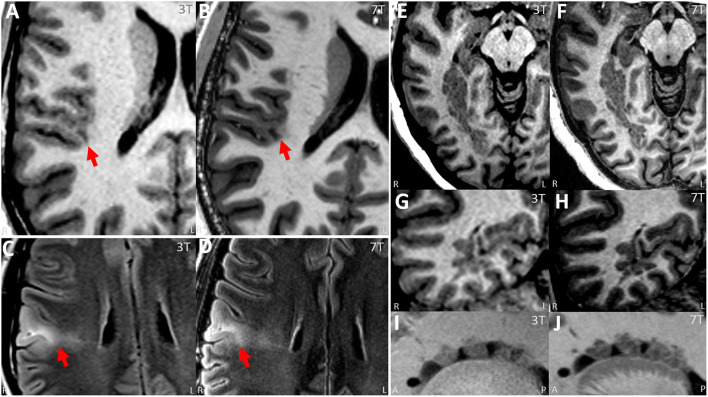
(A,B) Paired 3T−7T Images from a patient with histologically confirmed FCD IIB showing similar lesion presence, improved lesion conspicuity and improved boundary from the neuroradiologist team assessment. (A) Images from T1w MPRAGE sequence from 3T with arrow pinpointing the lesion. (B) Images from T1w MP2RAGE sequence from 7T at the same location, with arrow pinpointing the lesion. (C,D) Paired 3T−7T Images from another patient with histologically confirmed FCD IIB showing similar lesion presence, improved lesion conspicuity and improved boundary from the neuroradiologist team. (C) Images from T2w axial FLAIR sequence from 3T with arrow pinpointing the lesion. (D) Images from T2w axial FLAIR sequence from 7T at the same location, with arrow pinpointing the lesion. (E–J) Paired 3T−7T Images from a patient with nodular heterotopia showing similar lesion presence, improved lesion conspicuity and improved boundary from the neuroradiologist team. (E,G,I) Images from T1w MPRAGE sequence from 3T showing the lesion. (F,H,J) Images from T1w MP2RAGE sequences from 7T at the same location. (E,F) Axial zoomed, (G,H) coronal zoomed, and (I,J) sagittal zoomed.